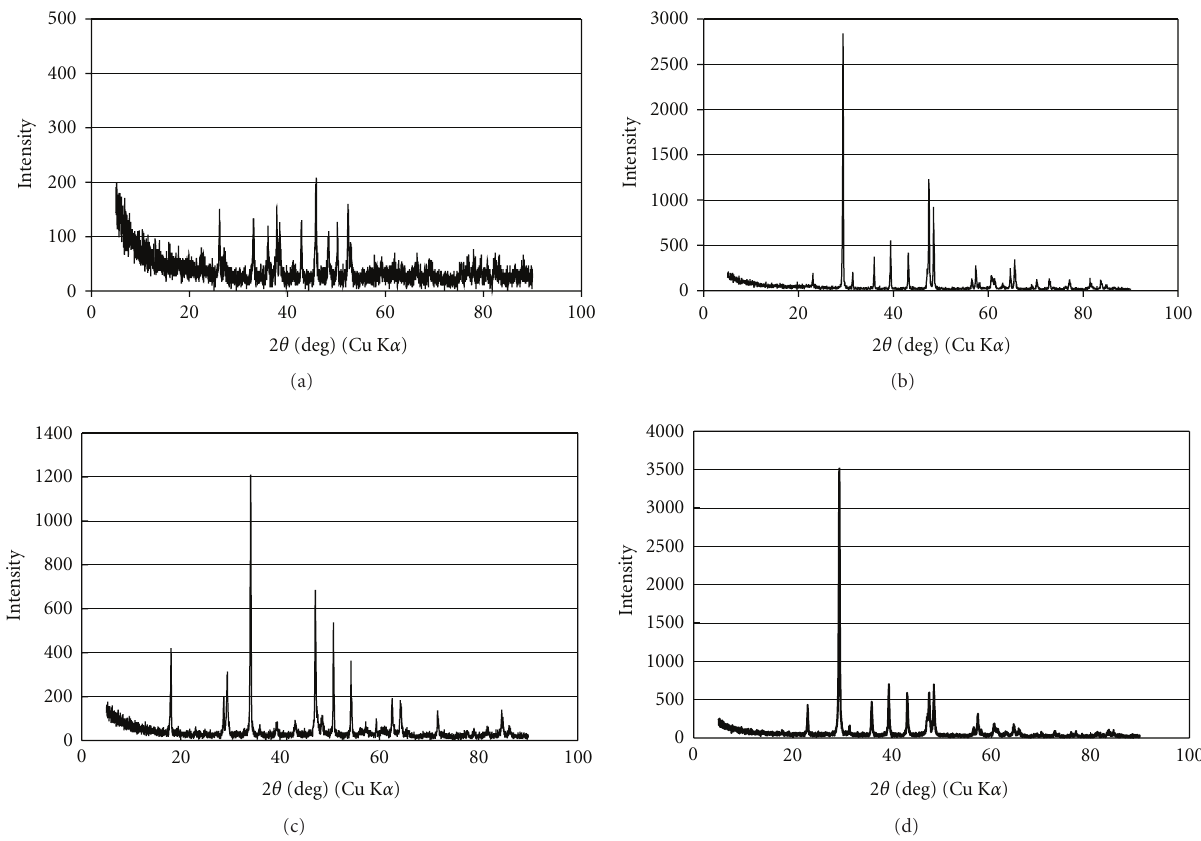
Figure 5: X-ray di ff raction (XRD) patterns of Buccinum tenussimum shell biomass after adsorption of metals. (a) ground original sample, (b) heat-treatment (480 ◦ C) sample, (c) heat-treatment (950 ◦ C) sample, and (d) heat-treatment (950 ◦ C) and water-added